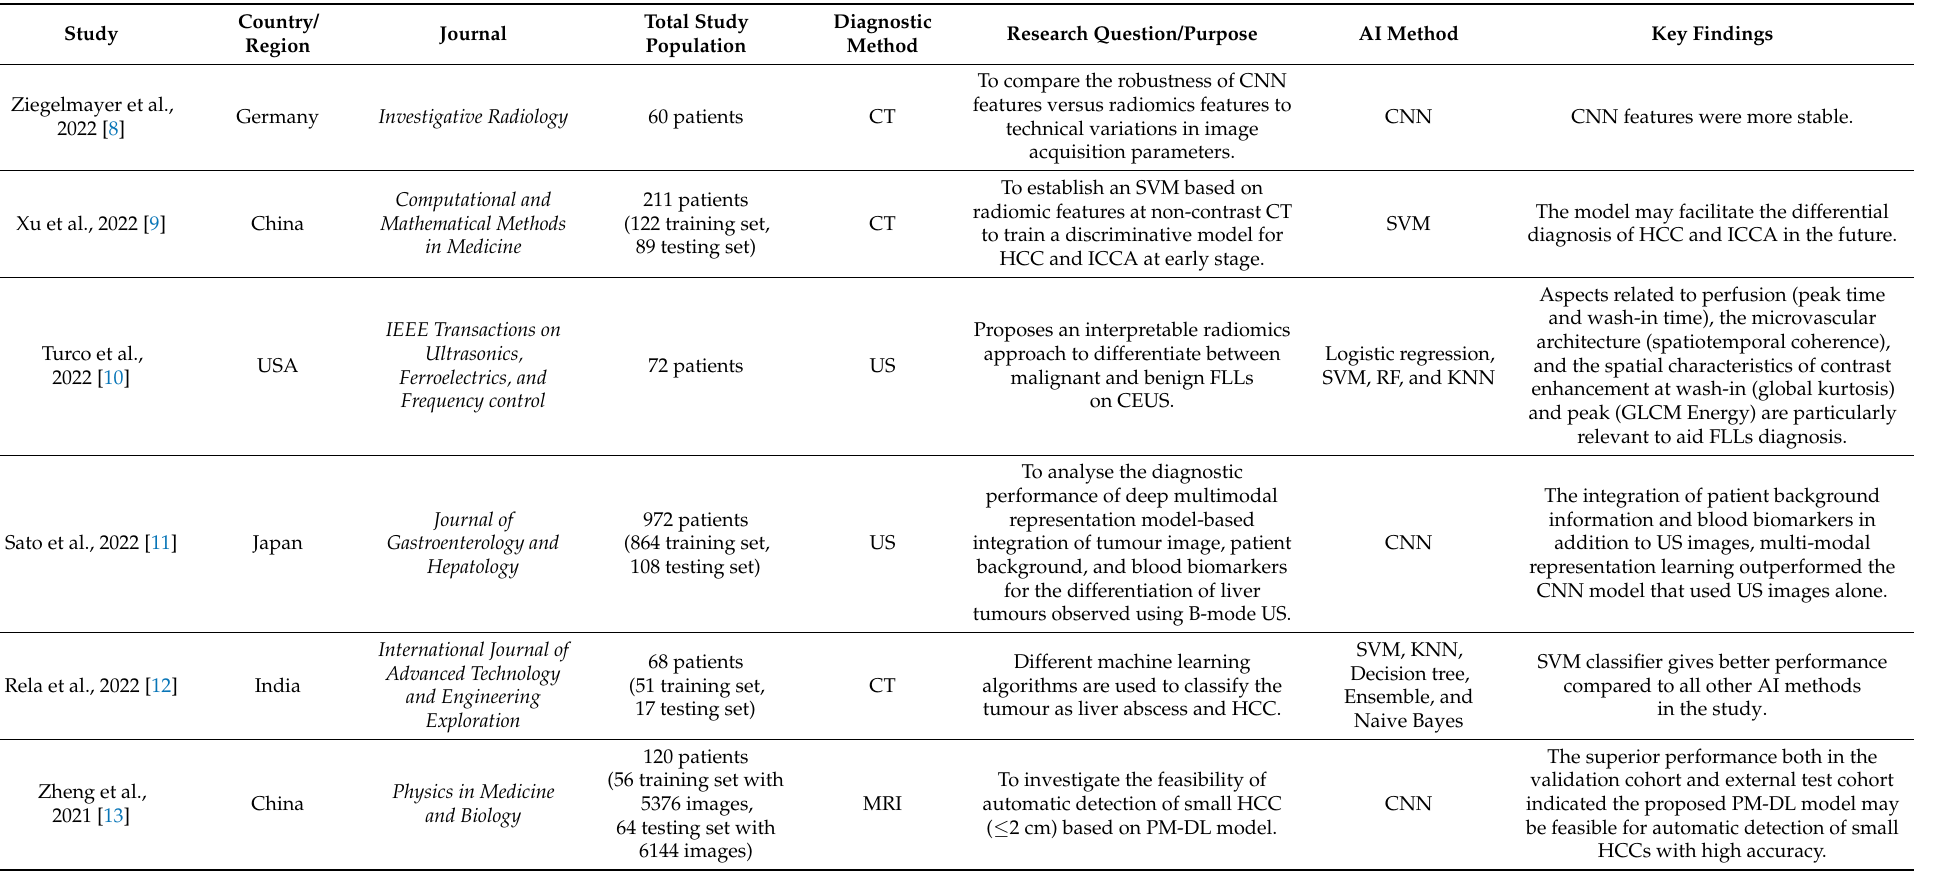
Table 7. Characteristics of the studies included in the systematic